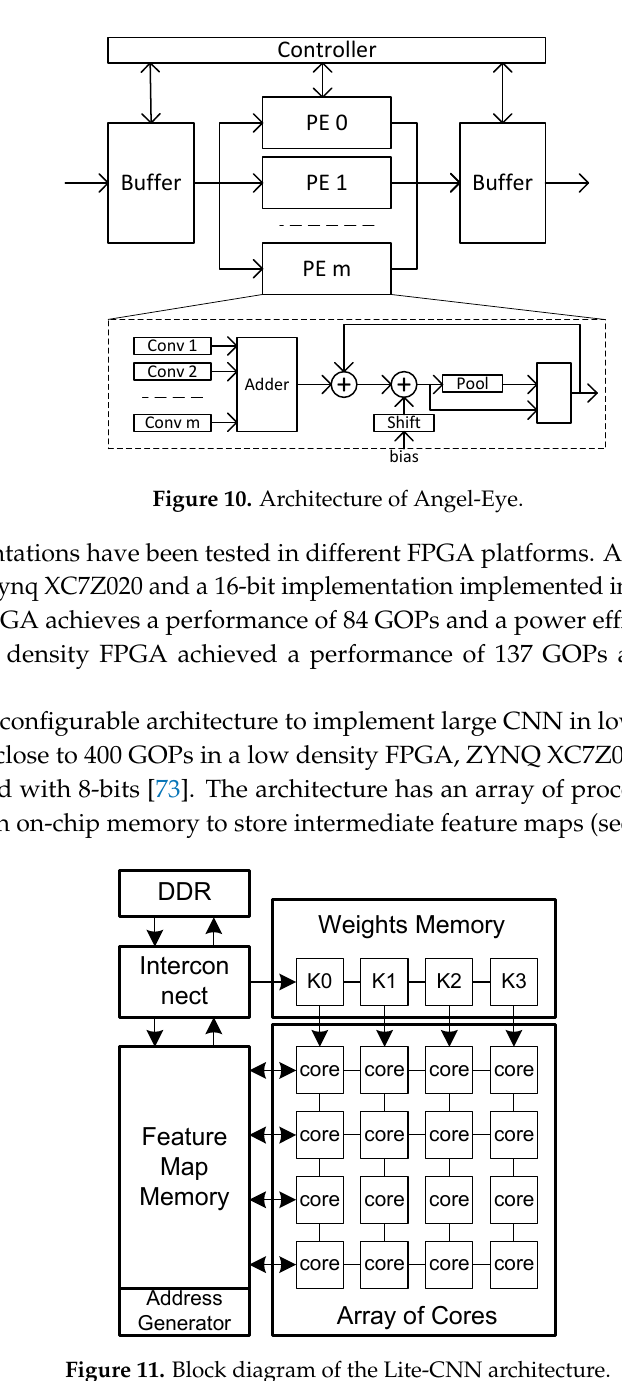
Figure 11. Block diagram of the Lite-CNN